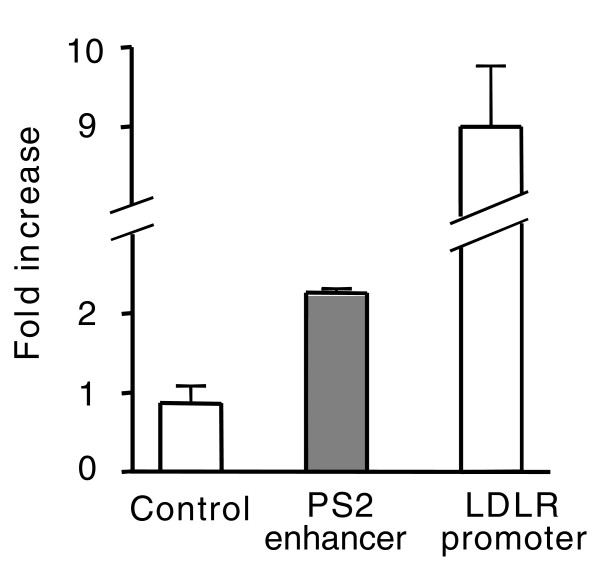
Anti-SREBP-2 antibody specifically enriches human PS2 DNA sequences in HepG2 cells in a ChIP assay. DNA precipitates were measured by real-time polymerase chain reaction using primers spanning the indicated regions. Control region (control) corresponds to the first coding exon of the neighboring gene SPBC24, which is approximately 7.5 kilobases away from the PS2 sequence. The results are presented as fold increase in the enrichment of precipitated DNA by anti-SREBP-2 (anti-sterol regulatory element binding protein-2) antibody over nonspecific IgG. Graphical representations of the mean ± standard error from three independent experiments are shown.